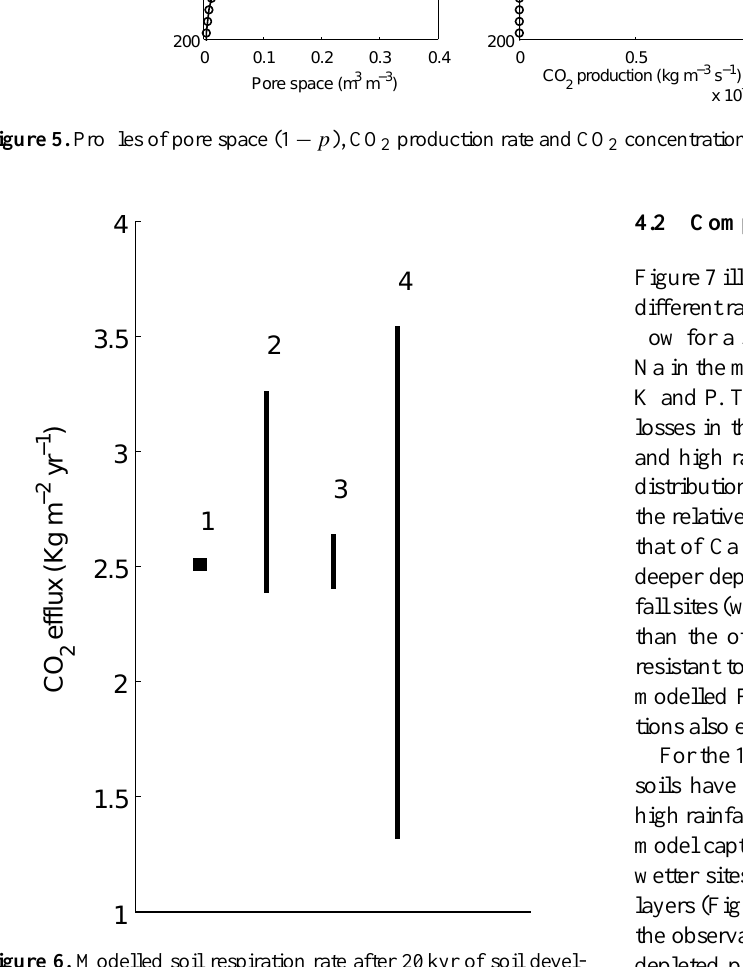
Figure 6. Modelled soil respiration rate after 20kyr of soil devel- opment (1) and ranges of measured soil respiration rates from the following studies of Hawaiian tropical soils (2) Raich (1998), (3) Townsend et al. (1995), and (4) Schuur and Matson